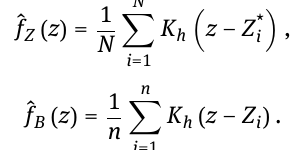
Table 3 indicates the average maximum likelihood estimators of θ parametric copula